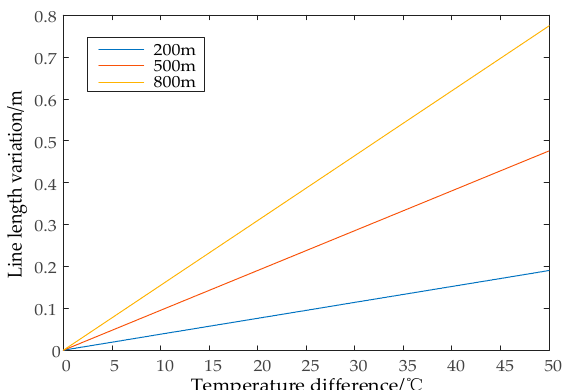
Figure 5. Length variations with different temperatures and conductor line lengths.